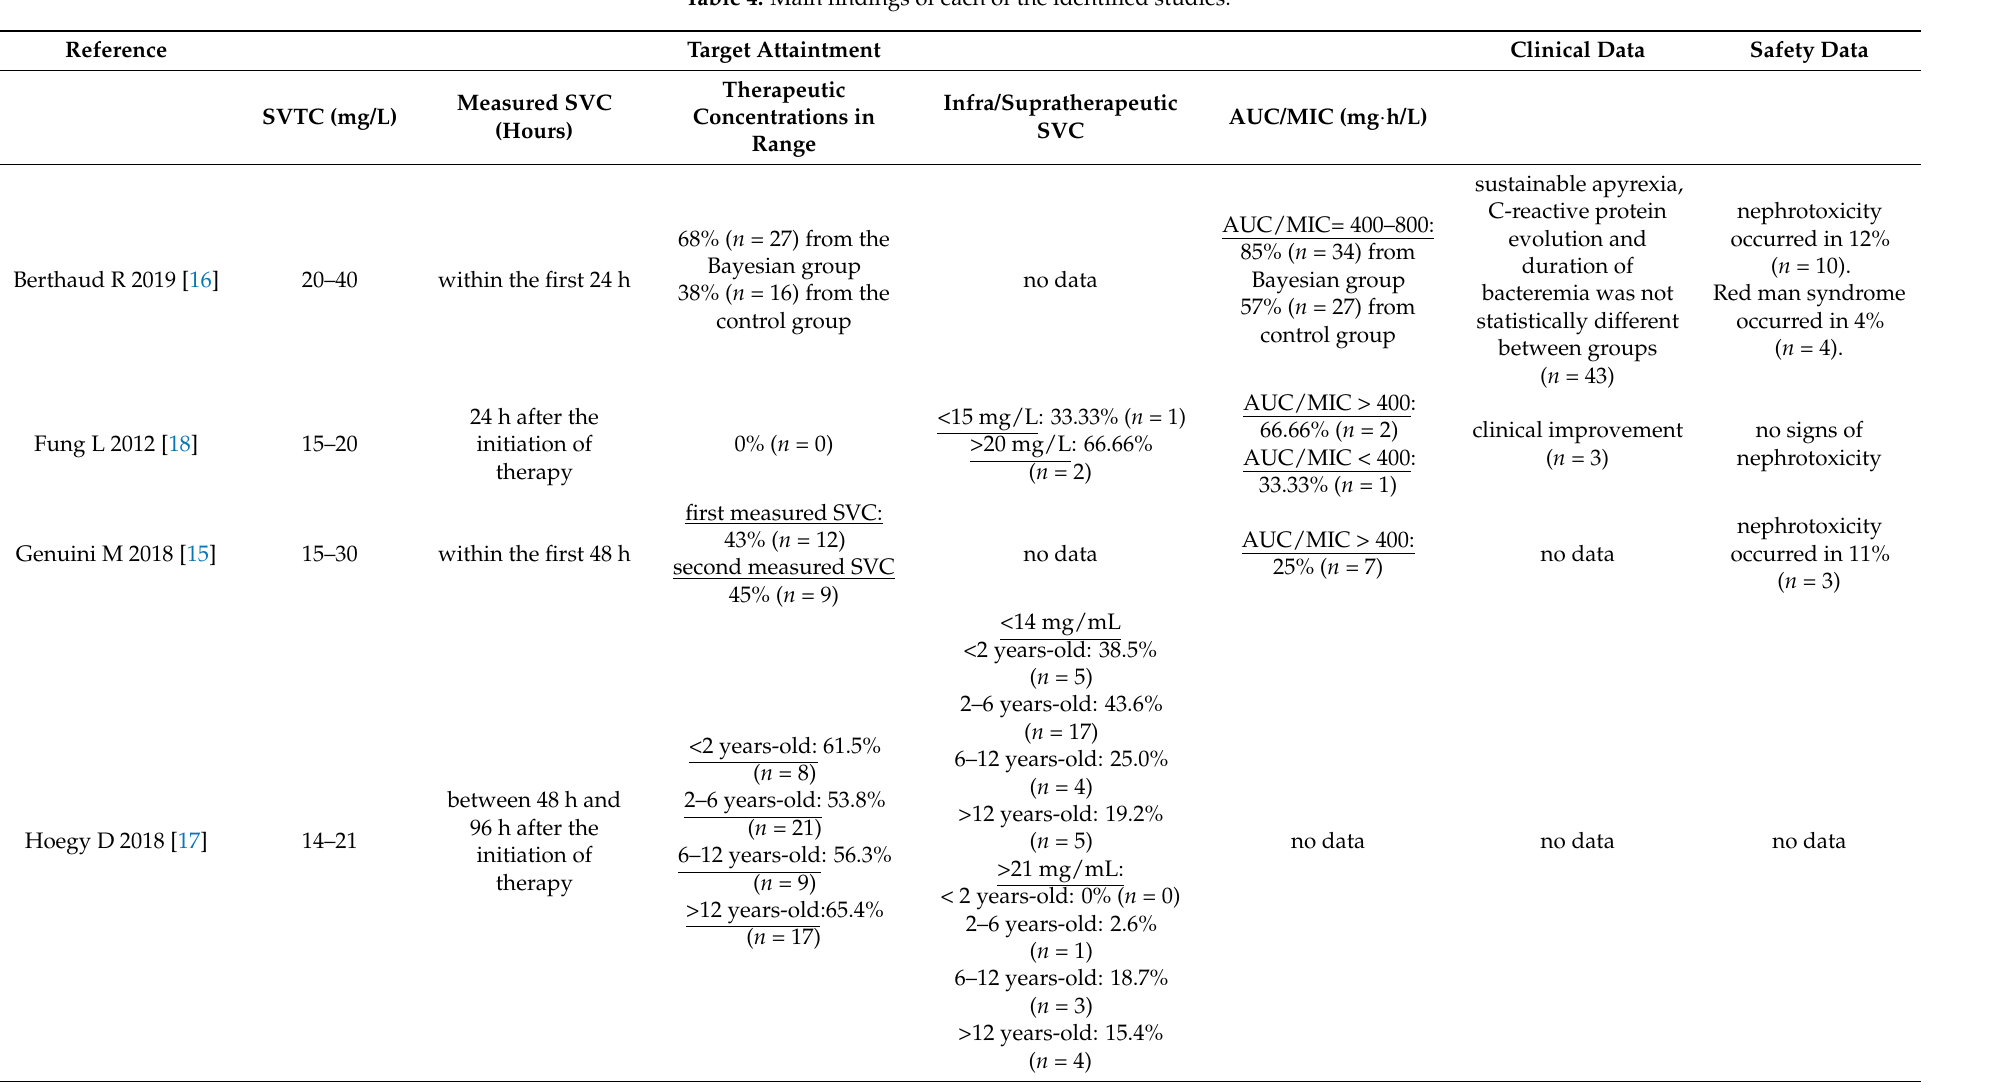
Table 4. Main findings of each of the identified